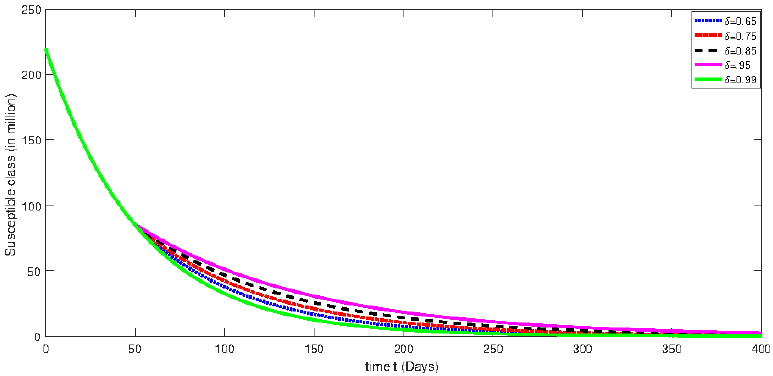
Figure 9. Numerical solution for susceptible class for the given days and using different fractional orders with isolation rate of 70%.